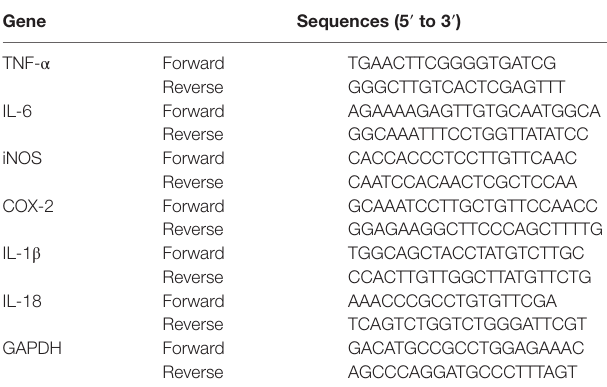
TABLE 1 | Primer sequences used for